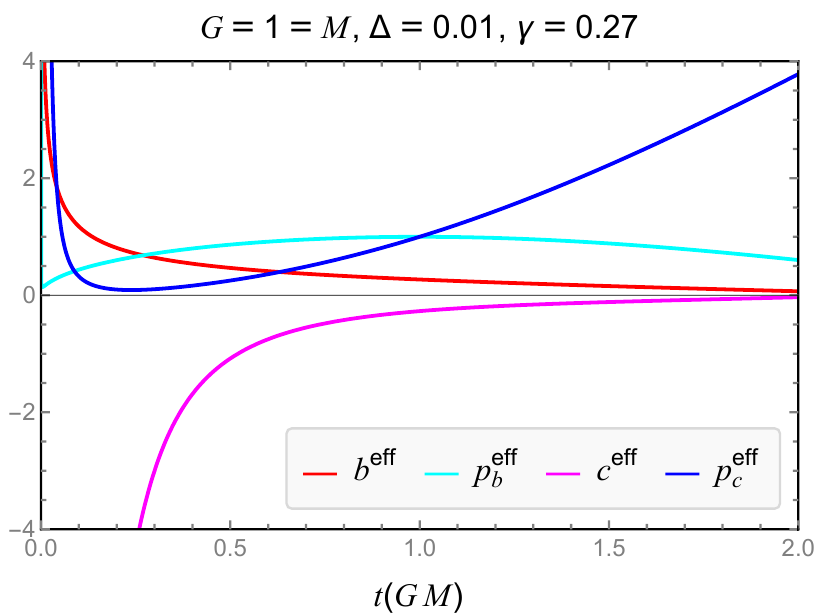
Figure 7. Solutions to the equations of motion in the ¯ µ case as a function of the Schwarzschild time t . Once again, p c never